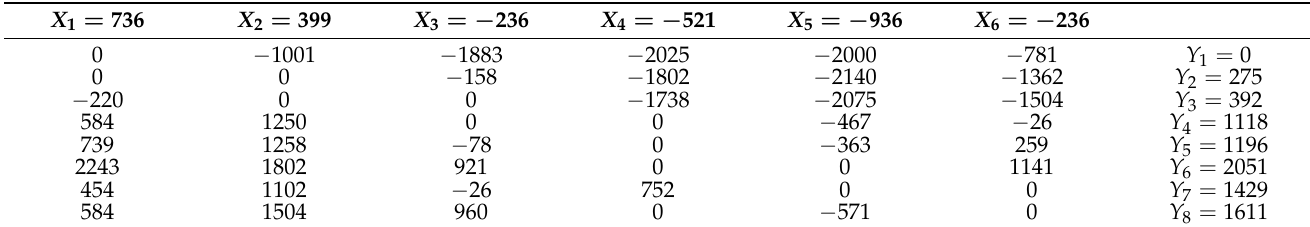
Table 11. Values of optimization indicators for solution obtained using northwest corner